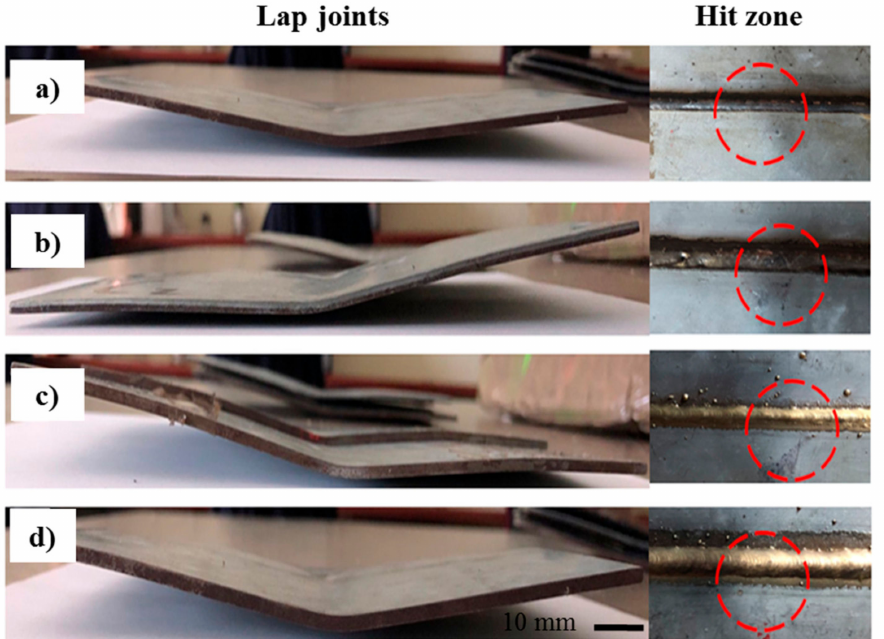
Figure 14. Free fall test. ( a ) GMAW-P low heat input, ( b ) GMAW-P high heat input, ( c ) GMAW-P -brazing low heat input and ( d ) GMAW-P-brazing high heat